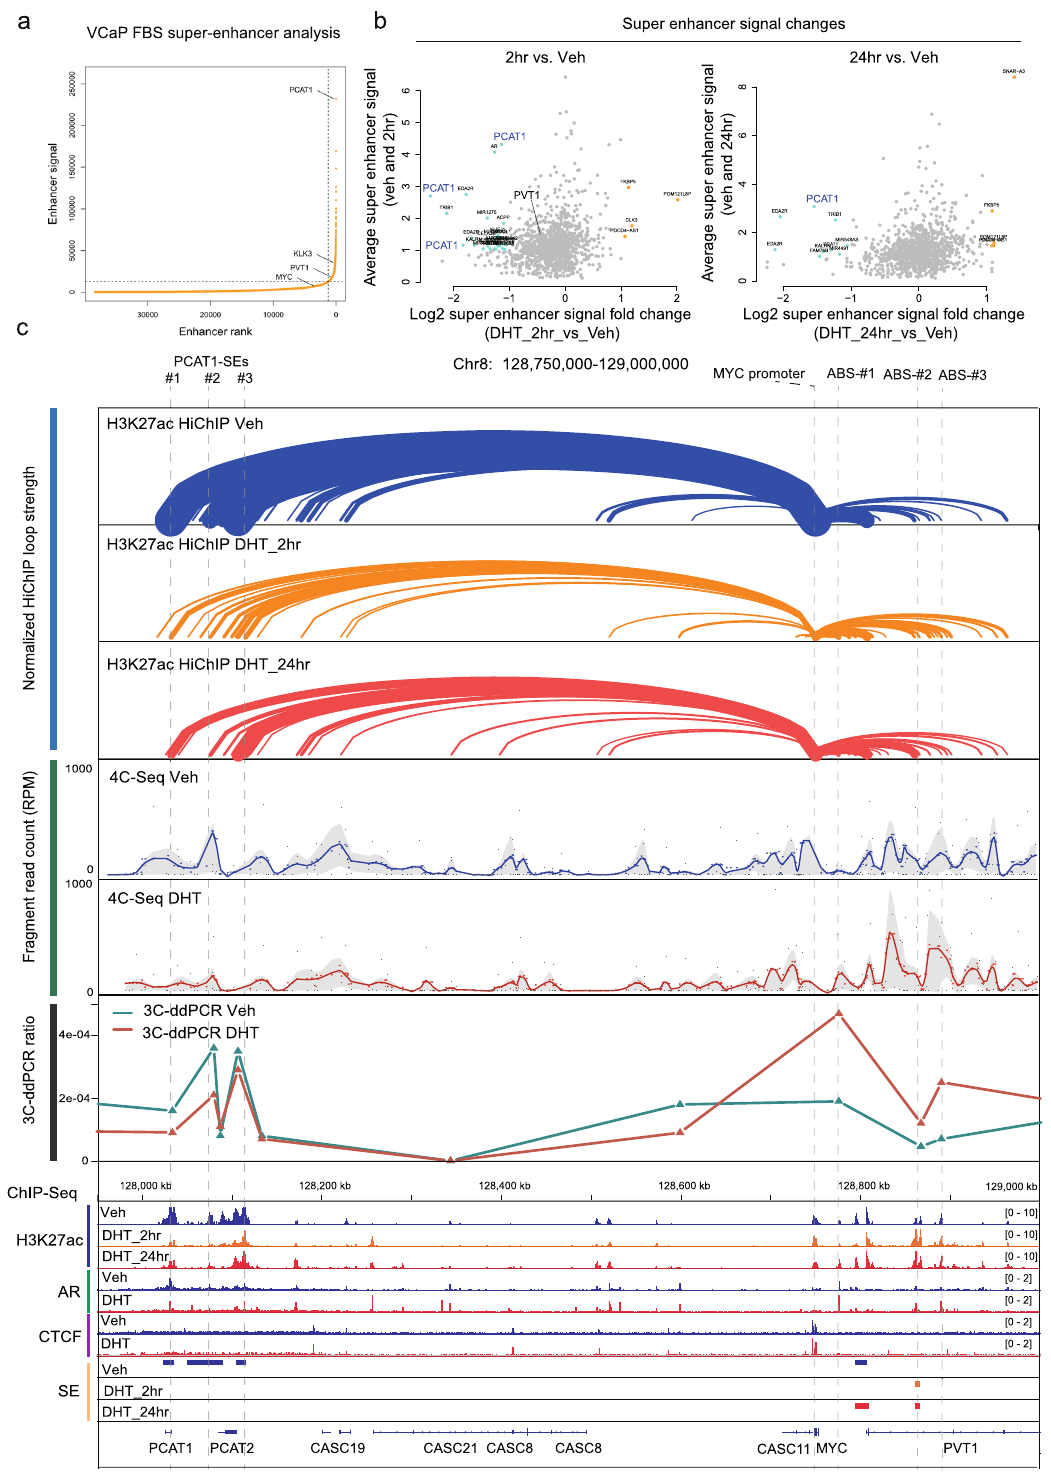
Fig. 6 8q24 super-enhancers drive MYC transcription by distal interaction that is perturbed by DHT treatment. a SE analysis of H3K27ac ChIP-seq data in VCaP cells cultured in regular medium. b H3K27ac signal fold change of all 1244 SEs under vehicle condition versus 2 h or 24 DHT stimulation. ( c ) Combined H3K27ac HiChIP and H3K27ac, 4C-seq, 3C-ddPCR, AR, and CTCF ChIP-seq annotation showing con fi dent interactions anchored at MYC promoter. For H3K27ac interactions, loops with less than 10 mated reads were fi ltered out. The 4C-seq and HiChIP results showed DHT stimulation attenuated the looping from MYC promoter to the left arm ( PCAT1 -SEs (#1, #2, and #3)) but enhanced the looping from MYC promoter to the right arm (ABS-#1, ABS-#2, and ABS-#3). For 3C-ddPCR, the MYC -promoter was used as bait (constant) that is paired with primers speci fi cally located in target